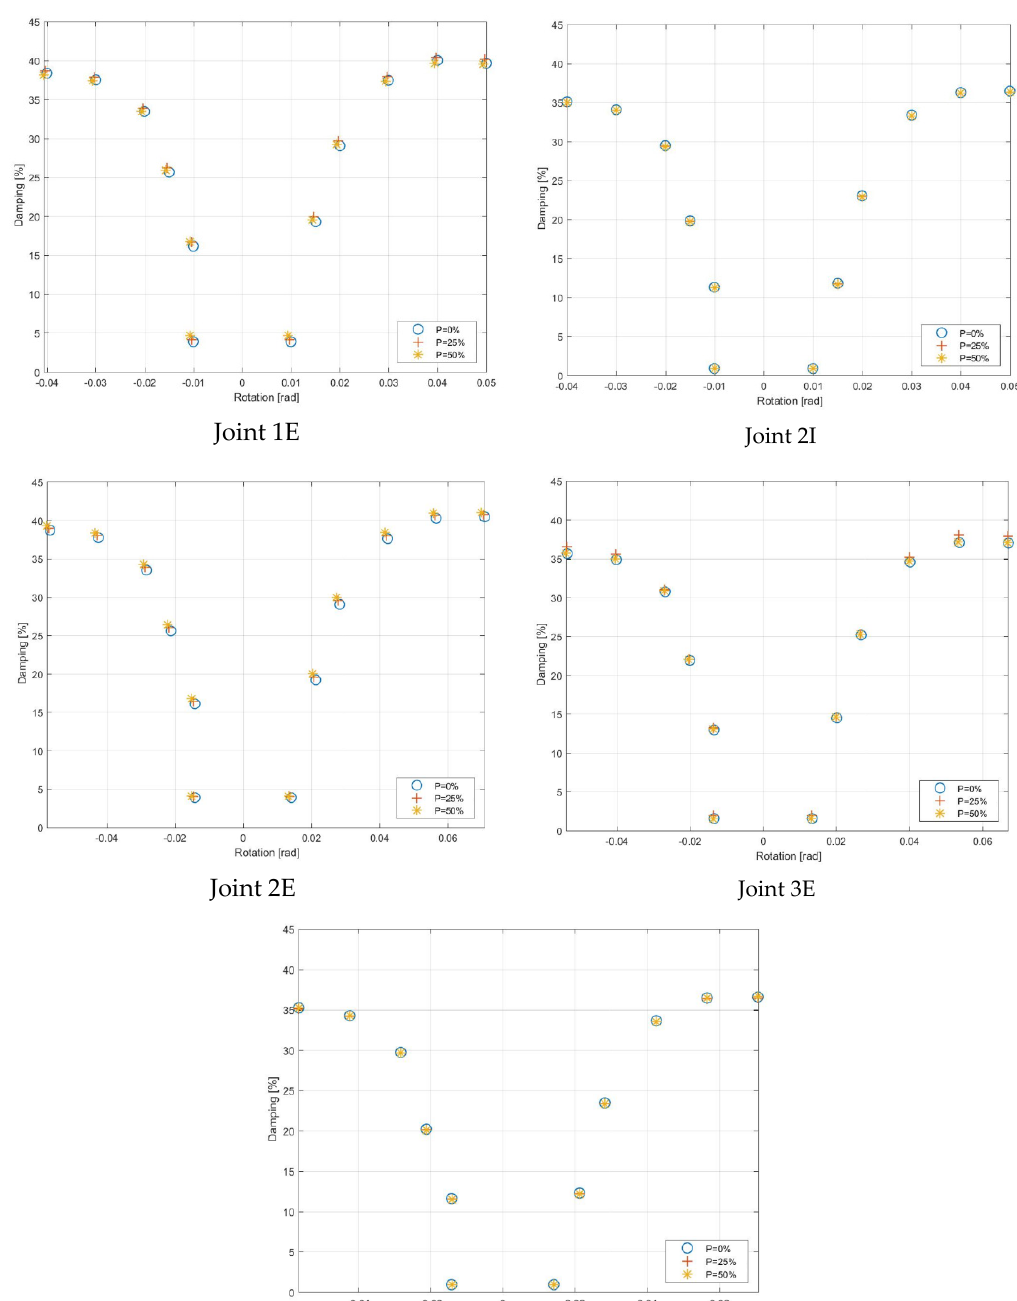
Figure 16. Summary of Equivalent Damping vs. Rotation according to equivalent load-displacement Method. Table 4. Summary of equivalent load-displacement results.